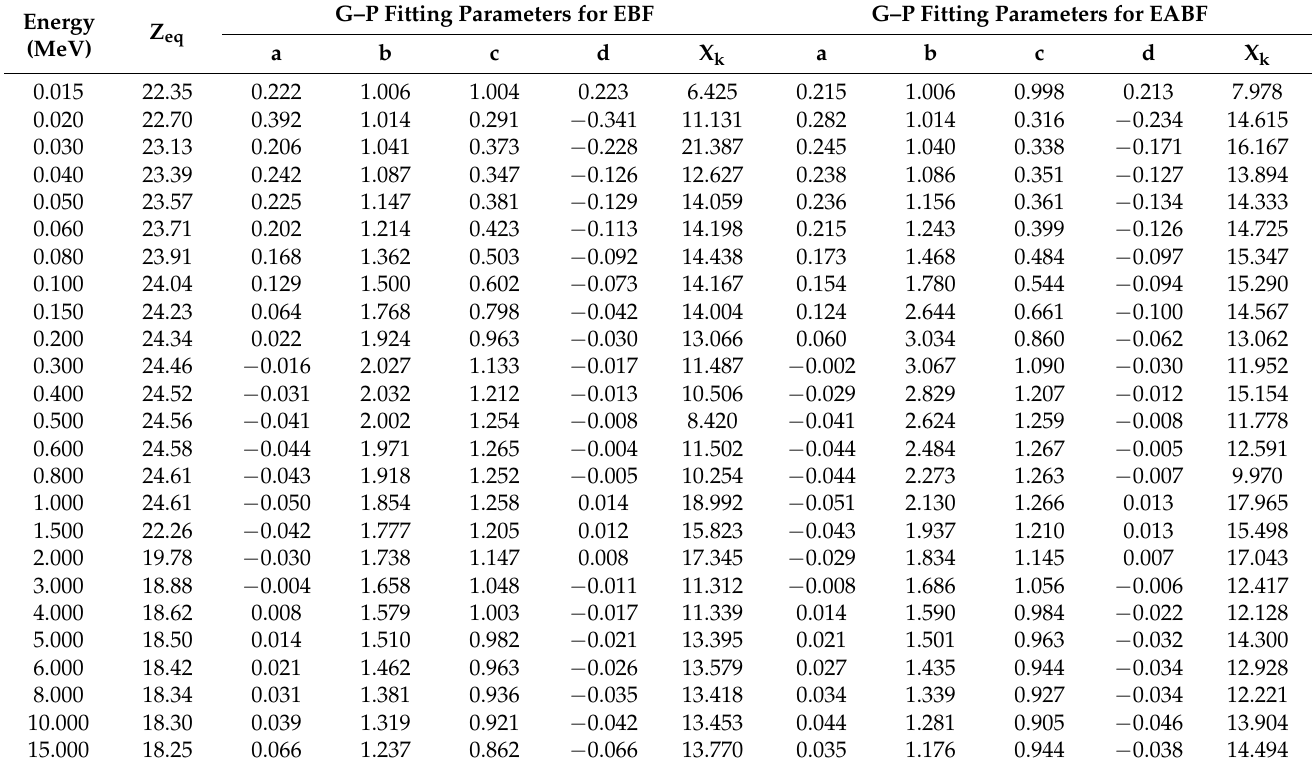
Table 4. (EBF and EABF) G–P fitting coefficients for the ZBV2 glass